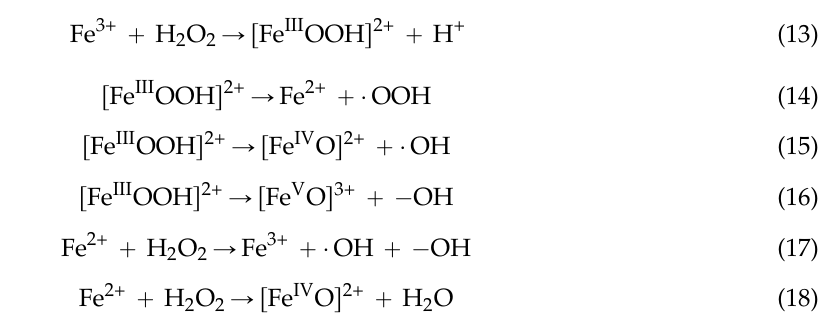
Figure 11. XRD spectra of α‐ Fe 2 O 3 @PHCMs before ( a ) and ( b ) after three repeated treatments. 3. Experimental Section